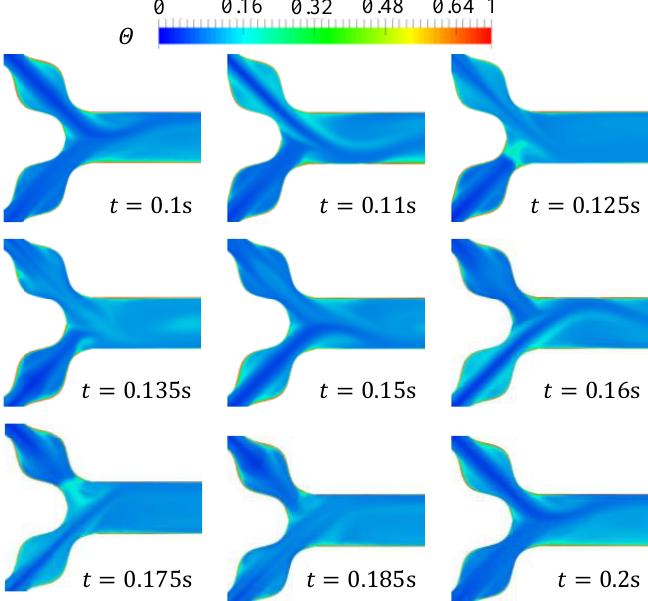
Figure 17. Evolution of temperature field during one pulse period.